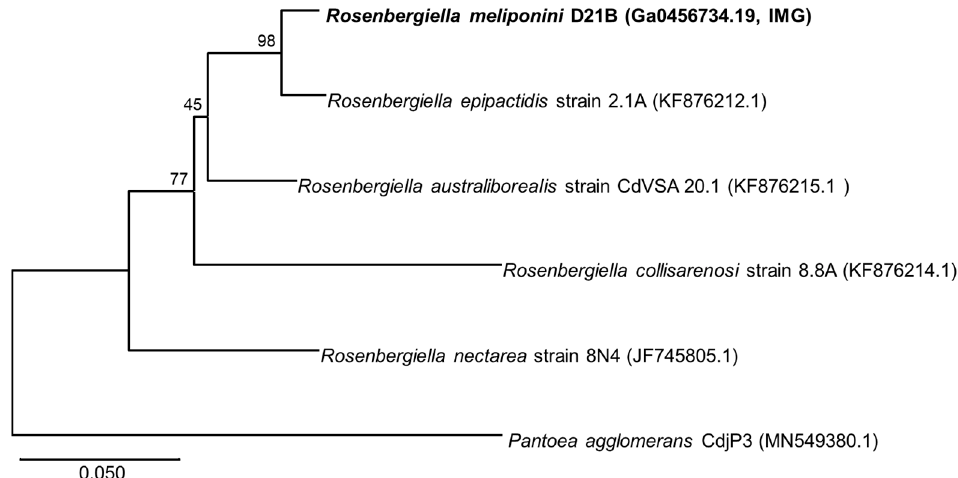
Figure 4. Neighbor-joining phylogenetic tree based on rpoB gene sequences. R. meliponini D21B rpoB and R. epipactidis 2.1A rpoB shared 97.43% sequence identity, whereas R. meliponini D21B rpoB shared less than 93.86% sequence identity with rpoB from R. nectarea , R. australiborealis , and R. collisarenosi . Bootstrap values > 45% calculated from 1000 replicates are indicated at branching nodes. Scale bar indicates 0.05 substitutions per nucleotide position. Table 2. Digital DNA-DNA hybridization (dDDH) values of R. meliponini D21B against sequenced Rosenbergiella strains calculated by TYGS (https://tygs.dsmz.de/) [40]. Legend: C. I.: confidence intervals, formula d0 (also known as Genome-to-Genome Distance Calculator (GGDC) formula 1): length of all high-scoring segment pairs (HSPs) divided by total genome length. Formula d4 (GGDC formula 2): sum of all identities found in HSPs divided by overall HSP length. Formula d6 (GGDC formula 3): sum of all identities found in HSPs divided by total genome